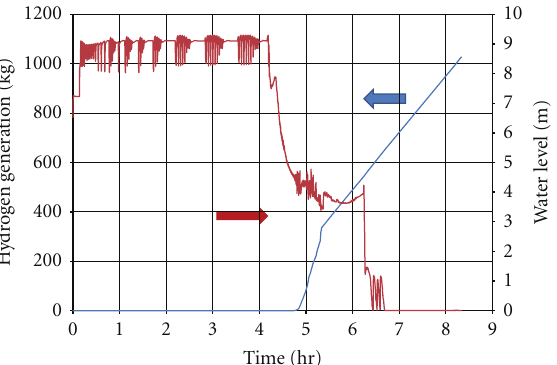
Figure 15: Hydrogen generation and water level for a scenario with depressurization and termination of emergency water injection at 4.2 hours after reactor scram (CRD flows maintained).